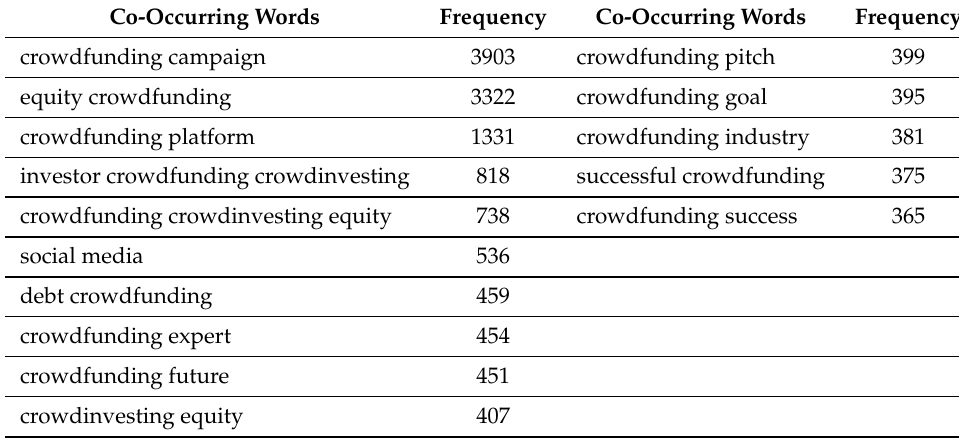
Table 6. Most Frequent Co-Occurring Words in Tweets of Top 50 Influencers.